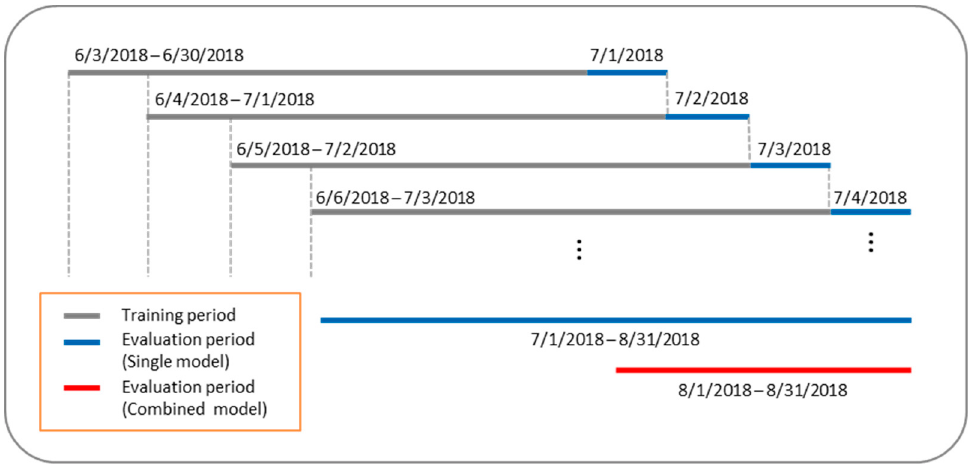
Figure 4. Training and evaluation periods for forecast.